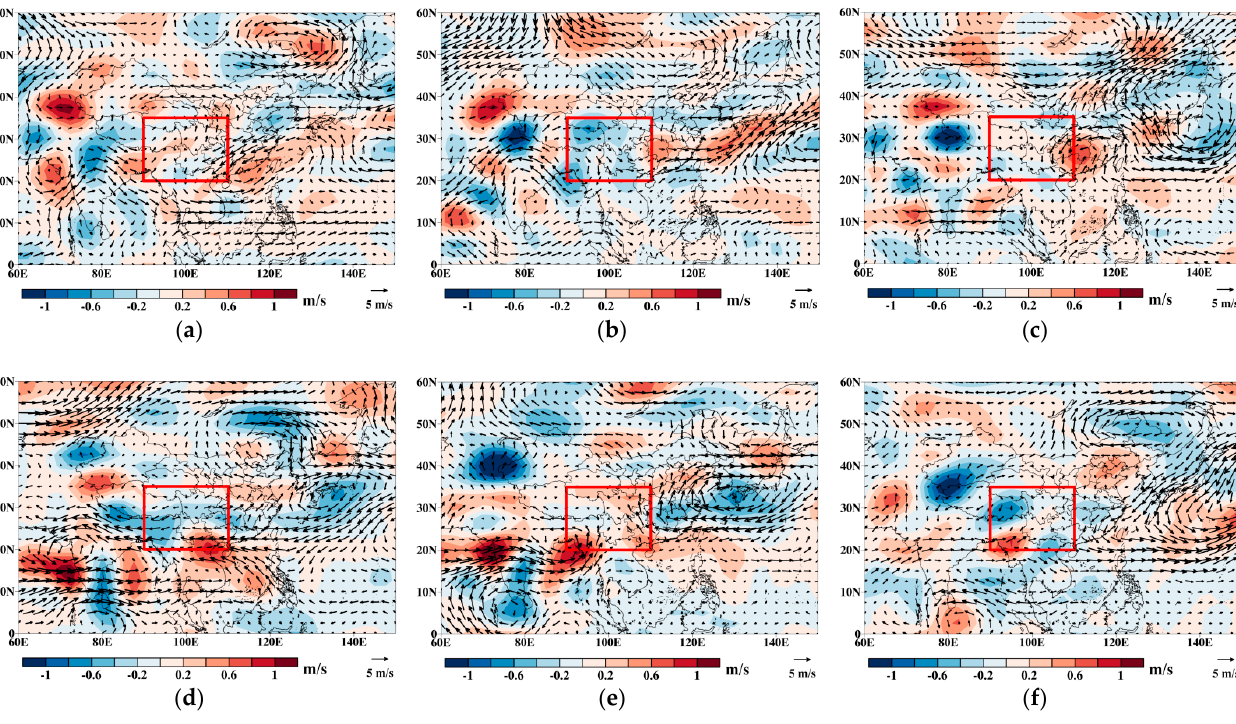
Figure 19. Homochronous 850 hPa wind field in the first cycle of the 30–60 days ISO in 1998. (Unit: m·s − 1 ; ( a – f ) means phases 1–6; area in red box is southwest China.).